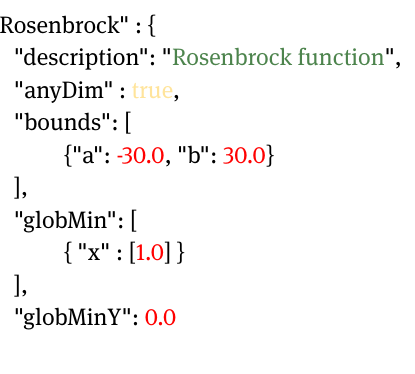
Figure 1: Rosenbrock function.